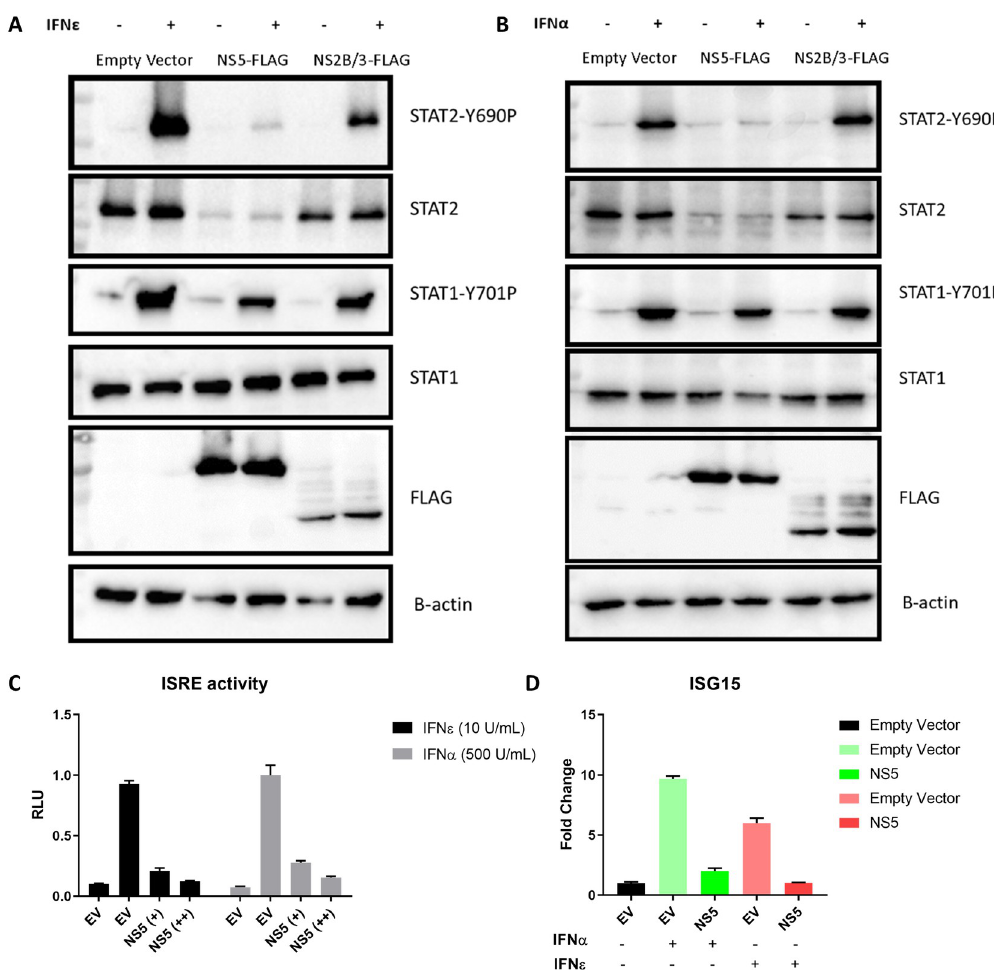
Fig 6. Evasion of IFN ε antiviral activity is mediated by ZIKV NS5 degradation of STAT2. A & B) HeLa cells were transfected with pCDNA6.2-ZIKV-NS5-FLAG, NS2B/3-FLAG or empty vector control and 24 h later stimulated for 30min with the indicated IFN prior to assessing total and phosphorylated STAT1/2 by immunoblotting. C) ISRE promoter activity was assessed following 24 h IFN ε stimulation in the presence or absence of ZIKV NS5A expression. D) HeLa cells were transfected with pCDNA-NS5-FLAG expression plasmid or an empty vector control (EV), 24h post transfection cells were stimulated with the indicated type-I IFN for 6 h prior to harvesting RNA for qRT-PCR analysis of ISG15 expression.